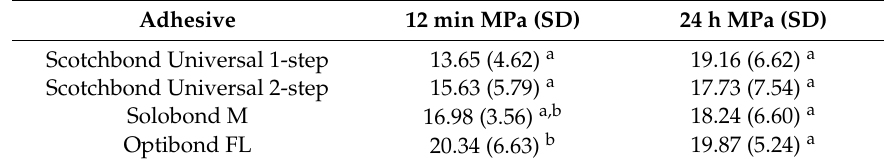
Table 2. Mean shear bond strength (SBS) values (MPa) and standard deviation (SD) by adhesion time.